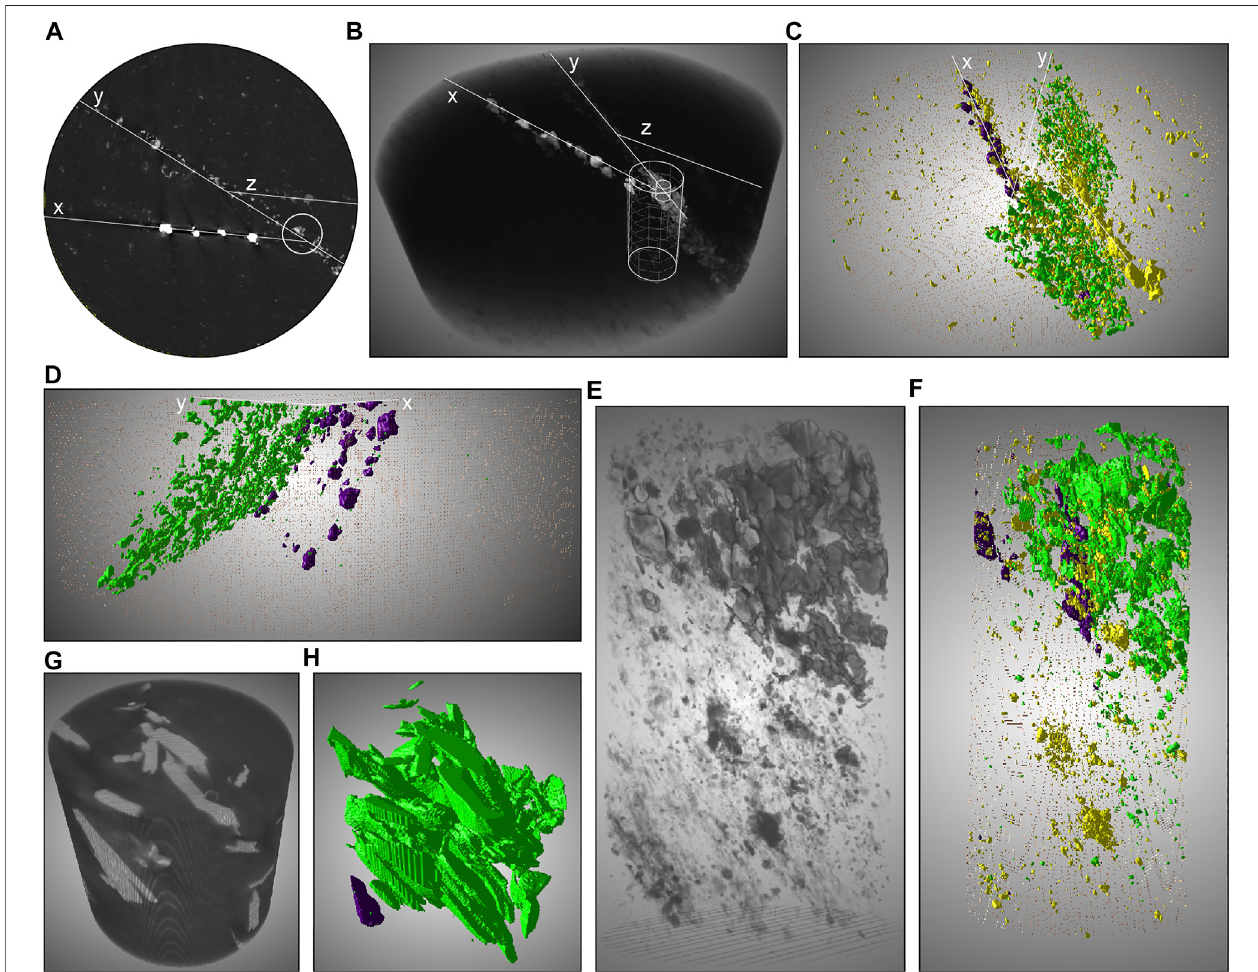
( Figure 8 ). For that reason, many molybdenite grains in the surface maps appear as thin elongated grains (cut more or less perpendicular to the crystallographic c-axis) rather than tabular fl